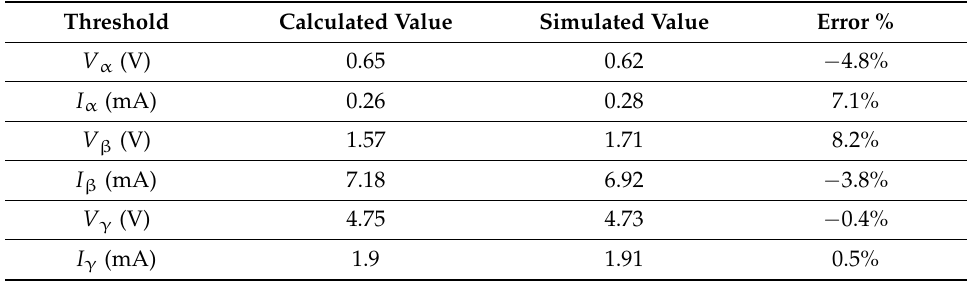
Table 2. Calculated and simulated threshold voltages and currents with pseudomorphic high-electron-mobility transistor (PHEMT).